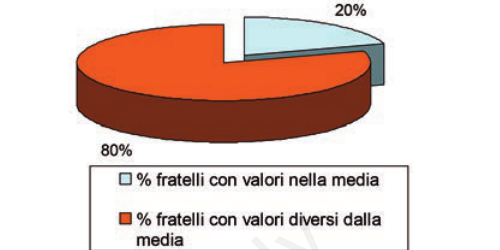
Figura 1. Percentuale di fratelli con sofferenza